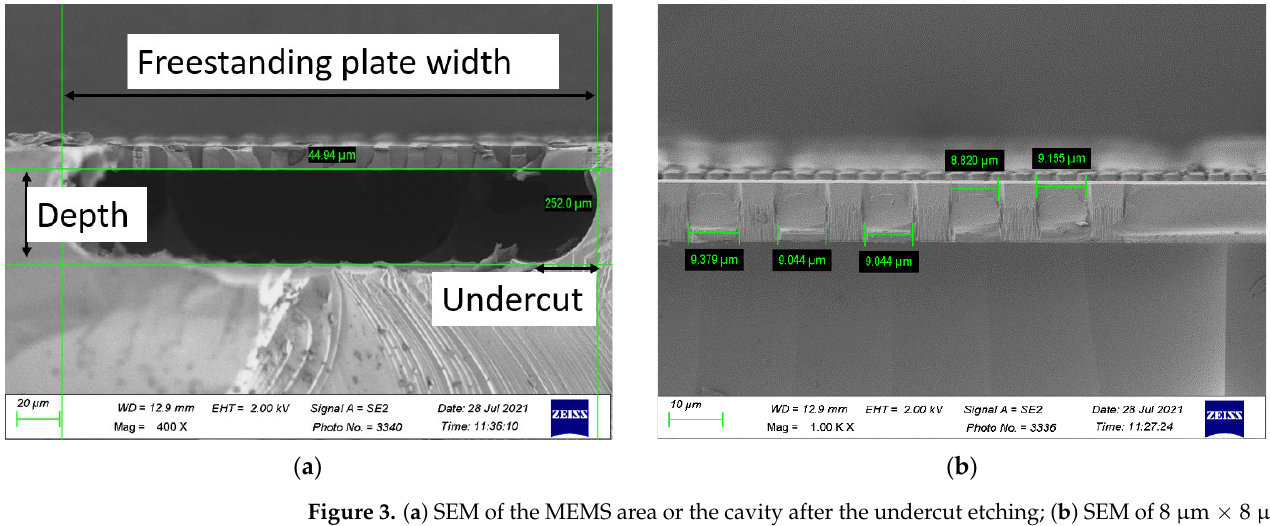
Figure 3. ( a ) SEM of the MEMS area or the cavity after the undercut etching; ( b ) SEM of 8 µm × 8 µm etch-holes (with measured 9.09 ± 0.28 µm in average) on CMOS layer. The MEMS area is freestanding plate with a membrane mesh.